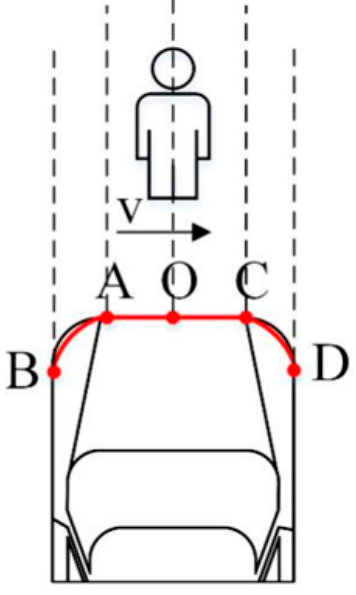
Figure 23. Pedestrian collision location.